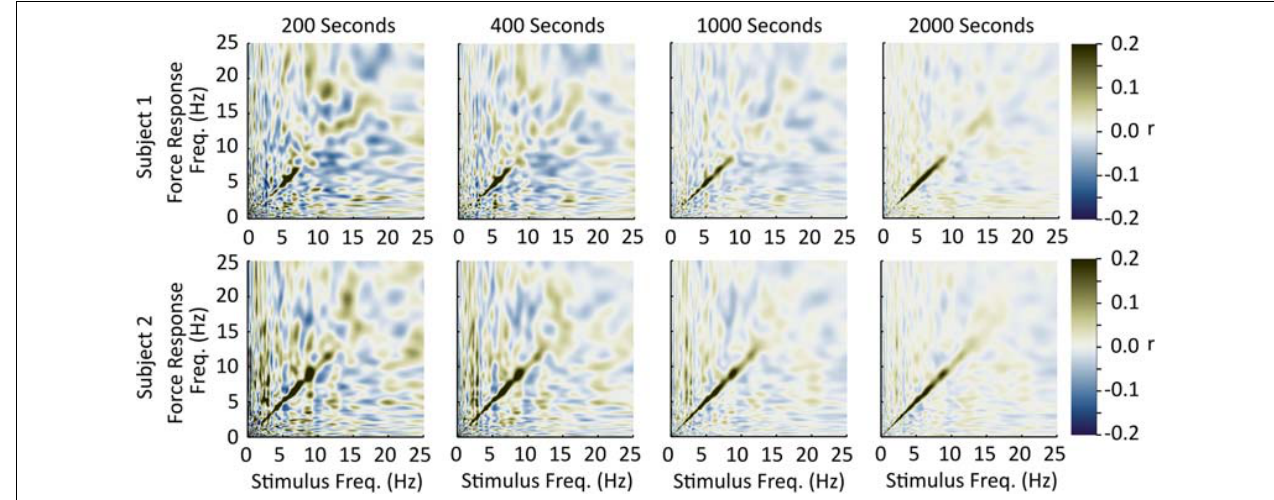
FIGURE 3 | Off-diagonal axis coupling and the effect of time. We collected two additional subjects [one male, 42 years, 190 cm, 95 kg (Top row); and one female, 27 years, 163 cm, 55 kg, (Bottom row)] using the same methods as the other 45 except for the duration of stimulation. These two subjects completed two 1040-s trials to examine the influence of increasing collection duration on off-diagonal axis correlations. In these two subjects, the strength of off-diagonal axis correlations decrease with increasing collection duration, suggesting that the off-diagonal axis correlations observed in the 45 subjects are largely due to the limited collection